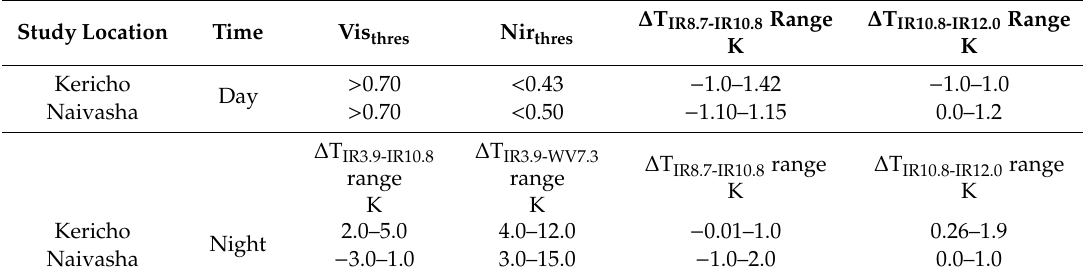
Table 6. Reflectance threshold and brightness temperature range used for rain